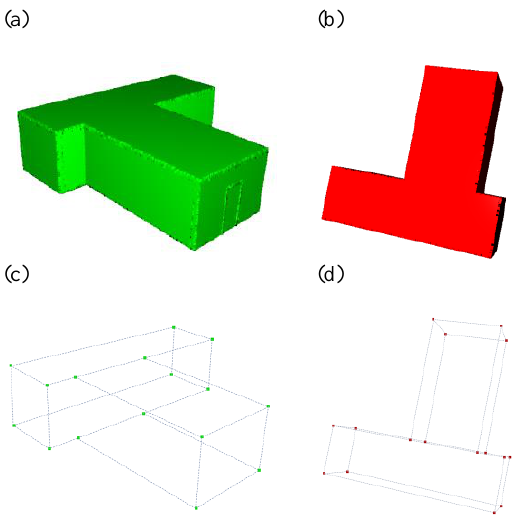
Figure 1. Visualization of corner points (c, d) extracted from their respective models (a,